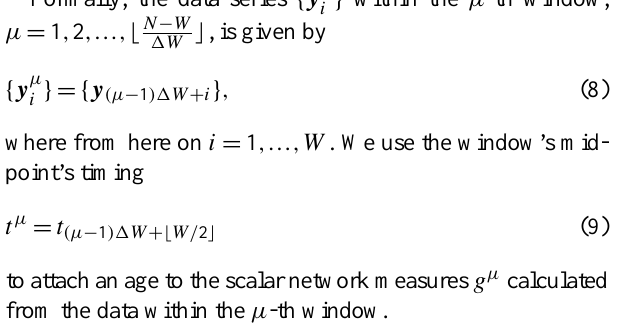
Fig. 4. (A) Probability distribution (PDF) p (∆ T ) of the sampling intervals of the three dust flux records according to their established age models (ODP sites 659: solid line, 721/722: dash-dotted, 967: dashed). The distribution for the δ 18 O record at ODP site 659 is vi- sually almost indistinguishable from that of the corresponding dust flux record and therefore not shown. The PDFs were estimated using a Gaussian kernel with bandwidth h = σ (∆ T )( N − 1) − 1 / 5 (Tab. 1) following Scott’s rule (Scott, 1982). (B,C,D) Temporal variation of the sampling times for the three dust flux records.